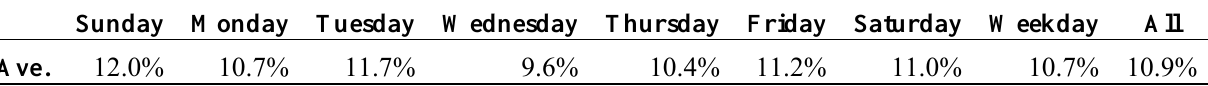
Table 6. Percentage of charging events (%).